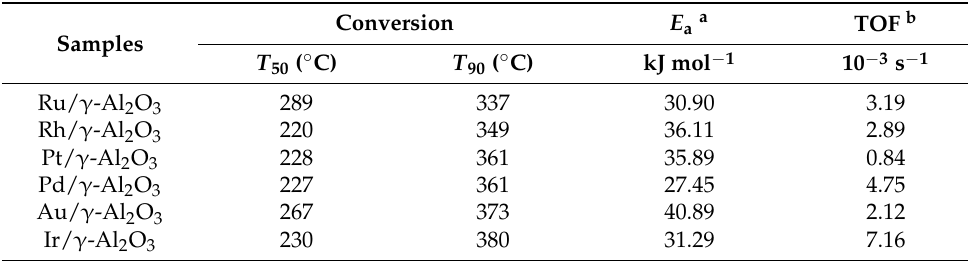
Table 1. Catalytic activity of synthesized